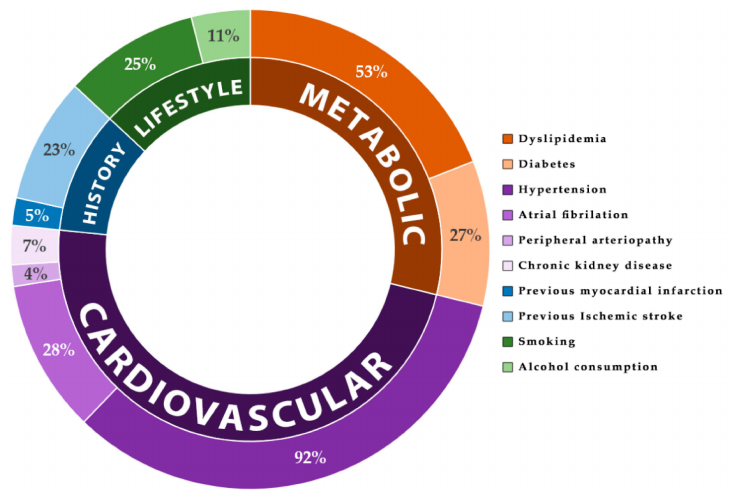
Figure 4. Risk-factor frequency